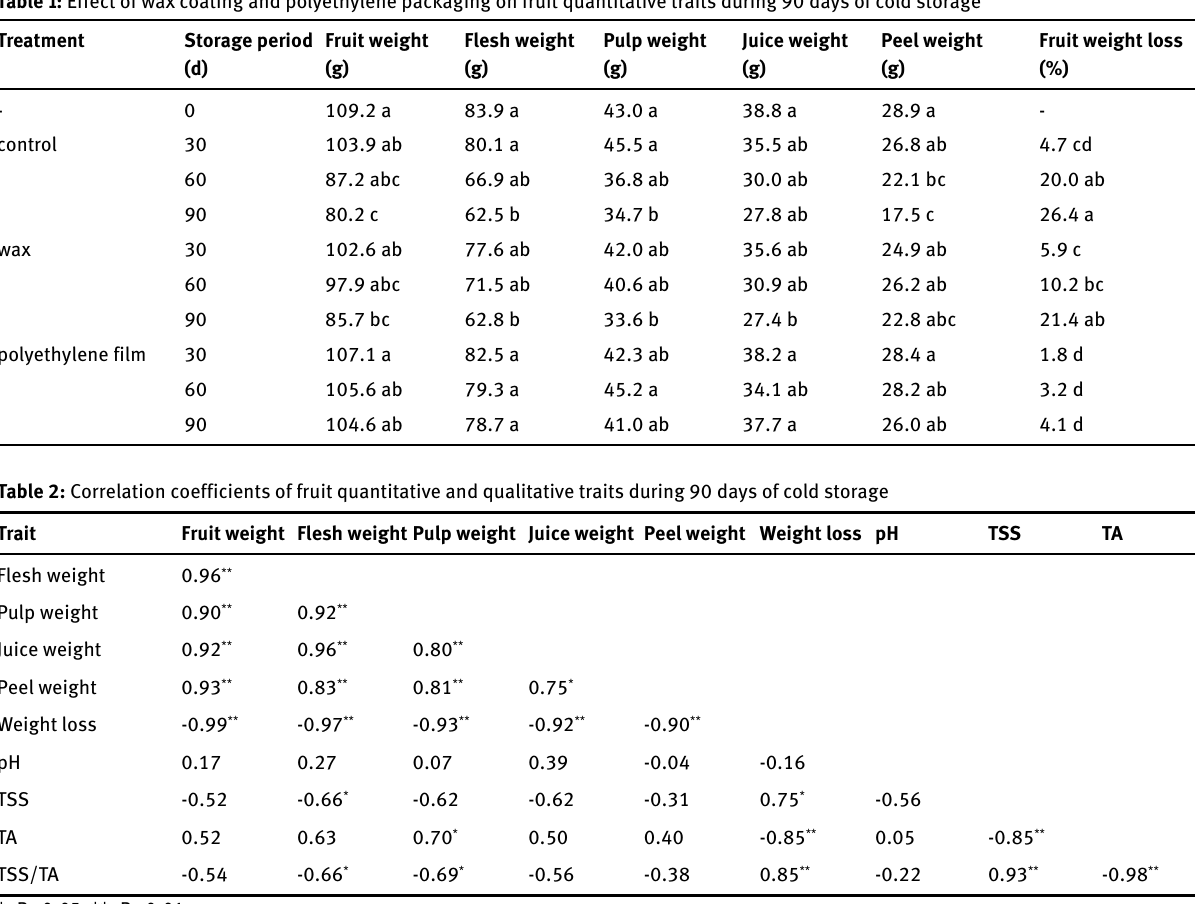
Table 1: Effect of wax coating and polyethylene packaging on fruit quantitative traits during 90 days of cold storage Treatment